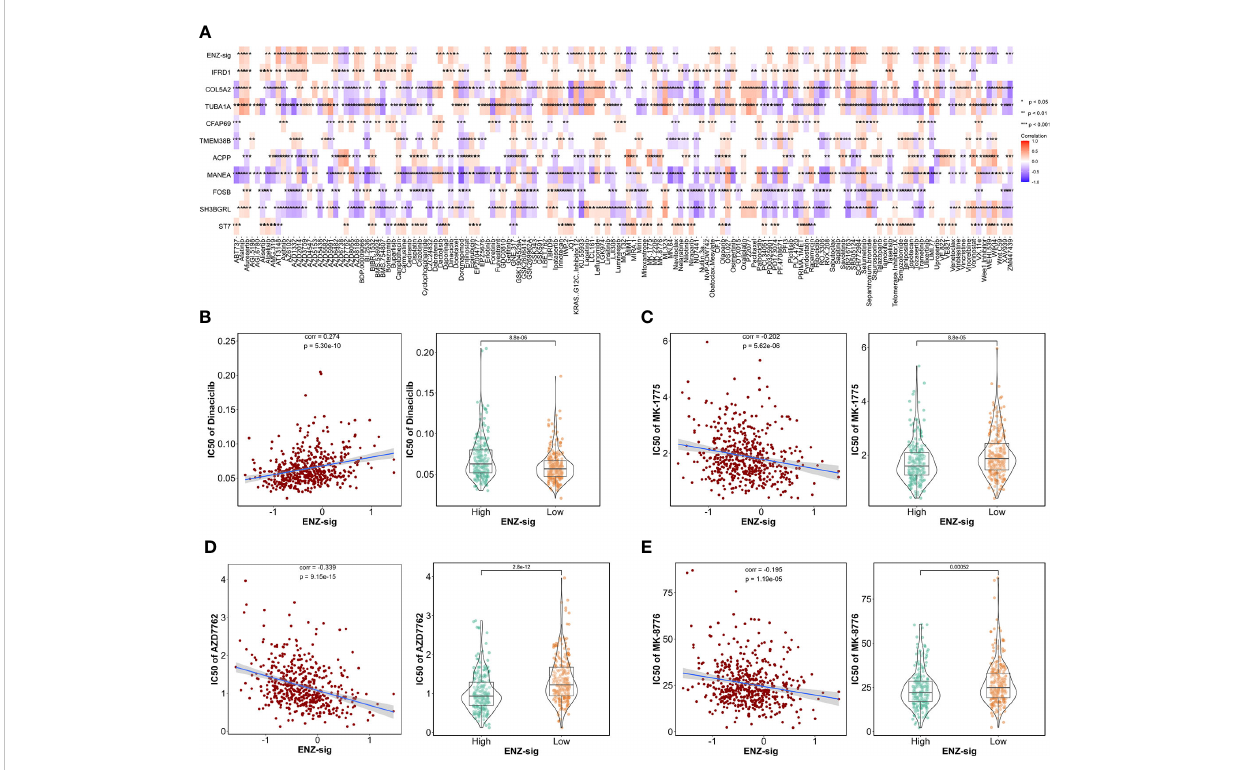
FIGURE 7 Ability of model in predicting drug sensitivity. (A) Heatmap plot indicates the correlation between drugs/compounds, ENZ-sig, and 10 ENZ-signature genes. Scatter diagram and box plot show the relationship between the sensitivity of dinaciclib (B) , MK-1775 (C) , AZD7762 (D) , MK-8776 (E) , and